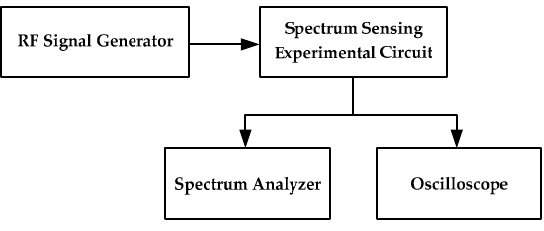
Figure 11. Setup for spectrum-sensing experiment.